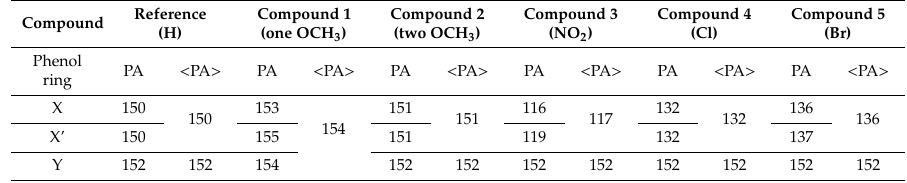
Table 3. Calculated proton a ffi nity (PA) values (kJ / mol) of the phenol rings (X, X’ and Y) in methanol.